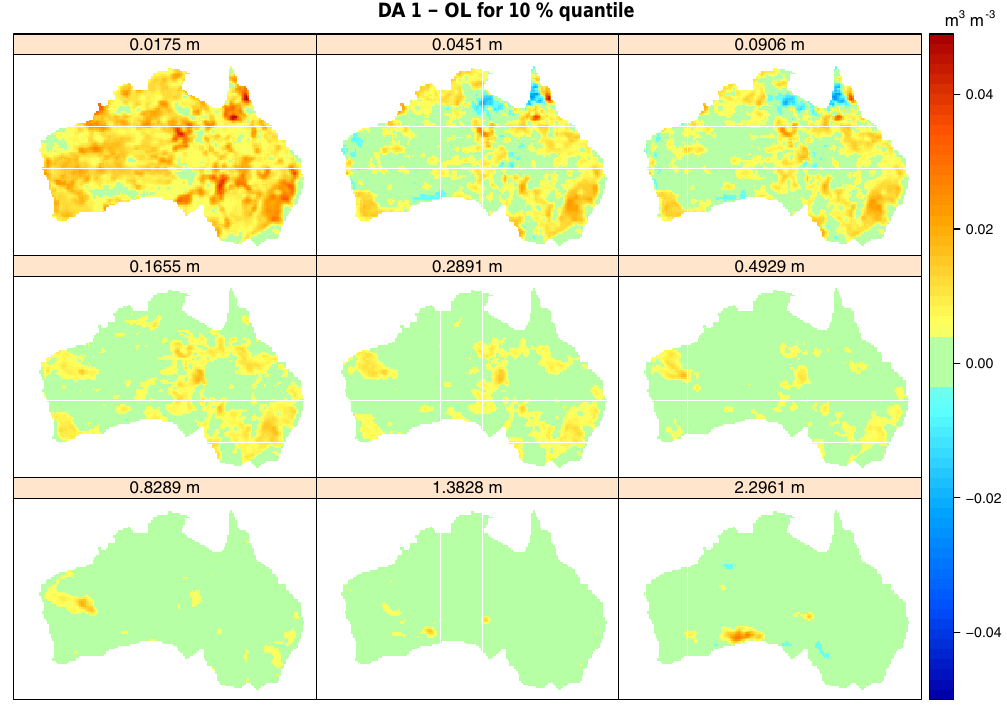
Figure 10. Differences in relative soil moisture between open-loop and DA 1 experiments (DA 1 – OL) for 10% quantile. The individual panels correspond to the top nine CLM soil layers titled with their